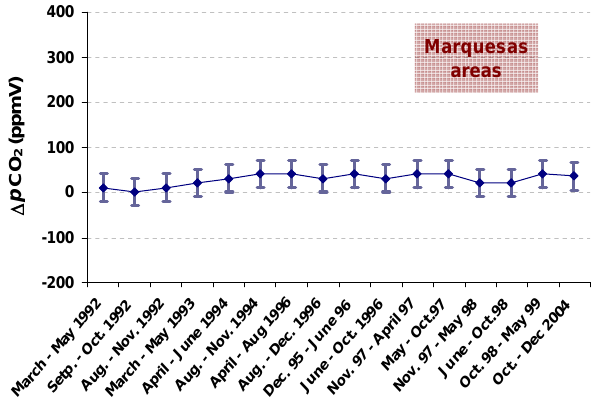
Fig. 8. The relative stability of modern 1p CO 2 values close to equilibrium in the Tahiti – Marquesas area between 1992AD and 2004AD (Dandonneau, 1995; Feely et al., 1999, 2002; Goyet et al., 2009; Goyet and Peltzer, 1997). the last deglaciation and +185 ± 25 ppmV at the end of the YD ( p CO 2 atm =250 ppmV). From similar calculations, the 1p CO 2 ( ∼− 15 ppmV) for the two modern corals (1950 AD, 1991 AD) from Tahiti (Fig. 7) are close to equilibrium as recently described by Takahashi et al. (2009) for this